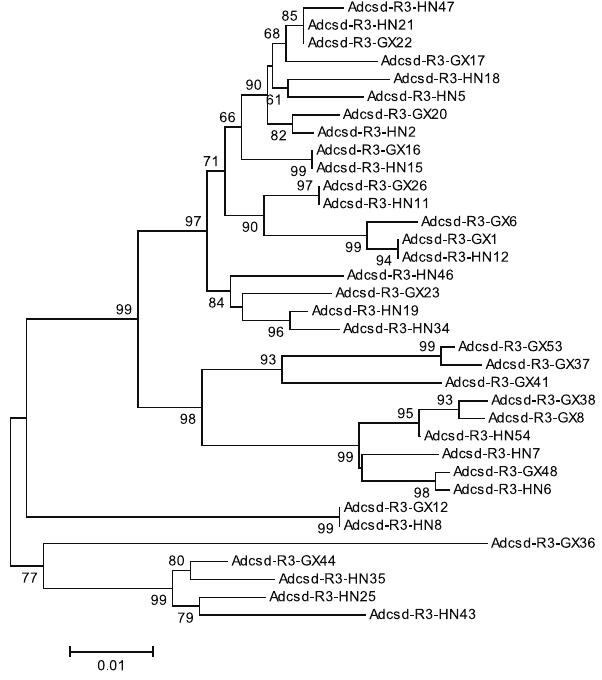
Figure 2. The gene genealogy of csd alleles in region 3 from Guangxi and Hainan A. dorsata populations. The minimum evolution method and Kimura’s two parameter distances were used to construct the tree. Bootstrap percentages are shown on internal branches. The scale bar represents the number of nucleotide changes per site. Geographical origin is indicated by letters: HN, Hainan; GX, Guangxi.